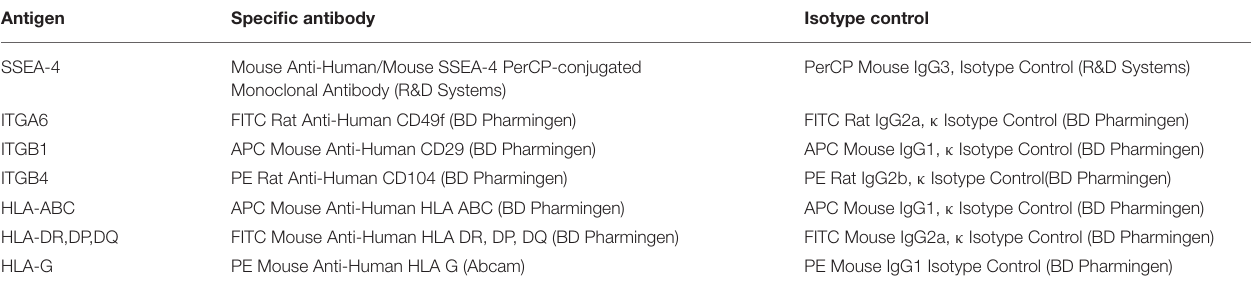
TABLE 2 | Antibodies and isotype controls used for flow cytometry. Antigen Specific